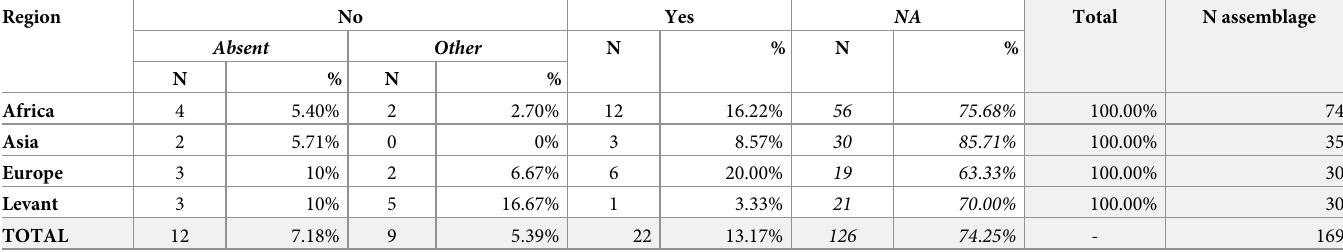
N: Number of assemblages per region. %: Percentage of assemblages per region. No: absence of intentionally broken bones. Absent: absence of bones. Other: bones are present but broken by carnivores or any other non-anthropic agents. Yes: presence of intentionally broken bones. NA : no information about the presence or absence of intentionally broken